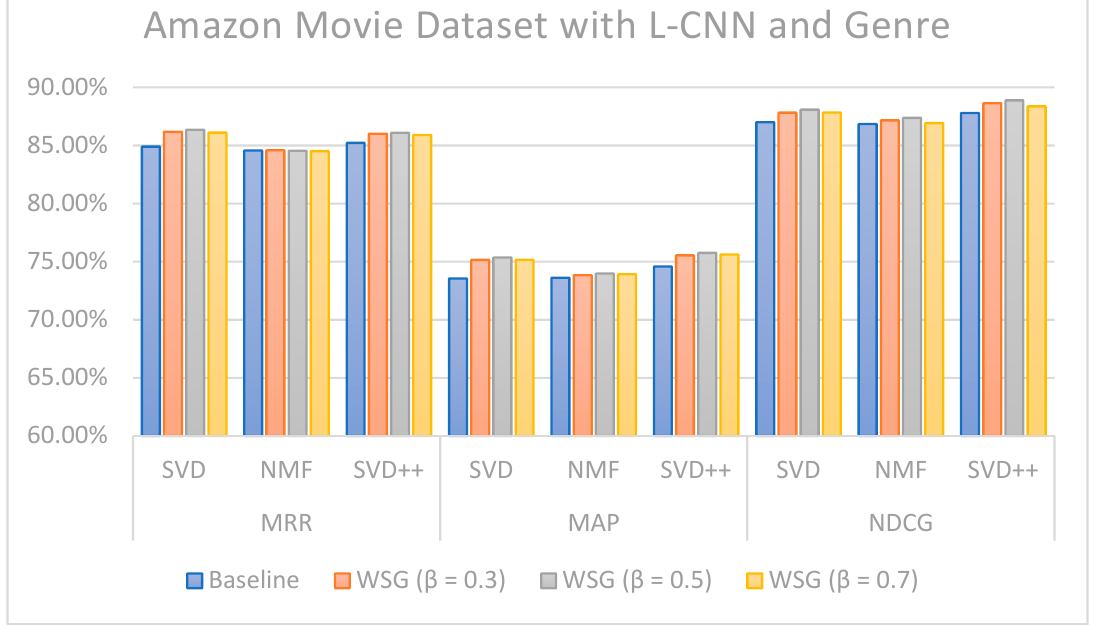
Figure 6. MRR, MAP, and NDCG values without and with L-CNN sentiment and genres-based model on Amazon Movie dataset with different 𝛽 values. Table 4. MRR, MAP, and NDCG values (%) without and with C-LSTM sentiment and genres-based model on Amazon Movie dataset with different 𝛽 values.